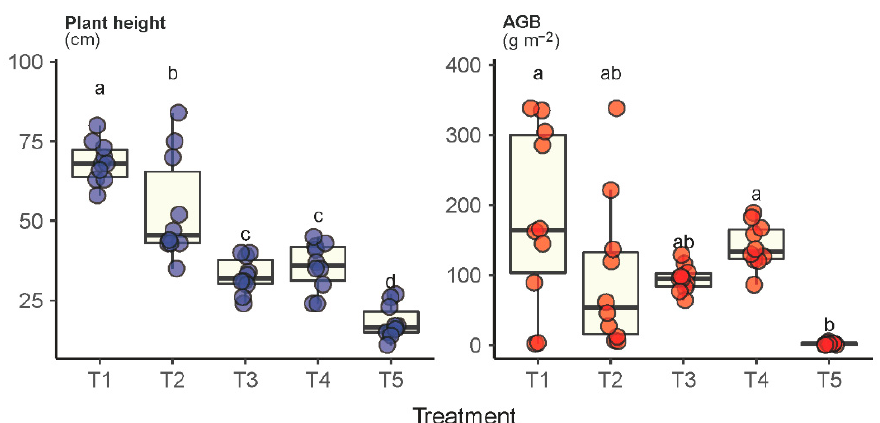
Figure 3. Plant height and aboveground biomass (AGB) of the dominant species Leymus chinensis under the experimental treatments T1 through T5. Treatments with the same lowercase letter are not significantly different.